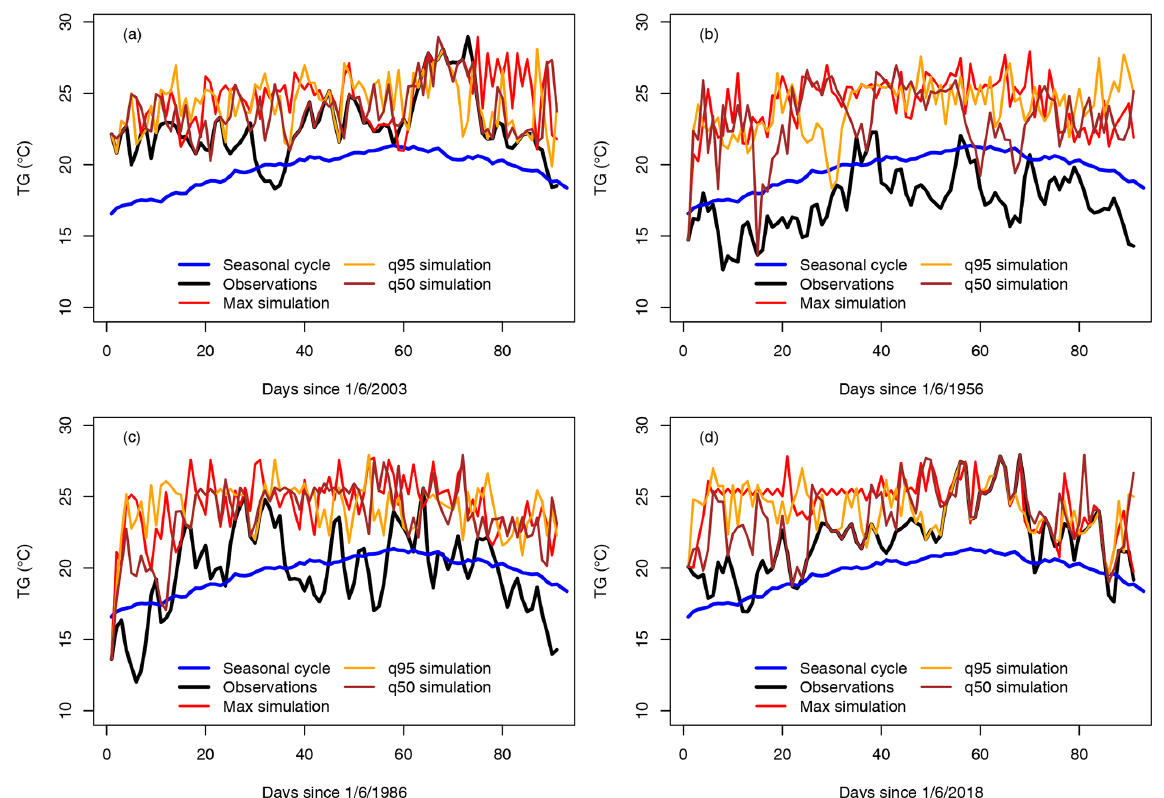
Figure 6. Observed and simulated daily temperature (TG) variations (for the Berlin–De Bilt–Orly–Toulouse–Madrid (BDOTM) average) for the four selected summers: (a) 2003, (b) 1956, (c) 1986 and (d) 2018. Temperatures are expressed in degrees Celsius. The simulation parameters are α cal = 5 and α = 0 . 5. The blue lines indicate the average seasonal cycle. The black lines are the observed TG. The red lines are the simulations with the highest JJA mean TG. The dashed lines are the simulations with the 95th quantile of JJA mean TG. The brown lines are for the median